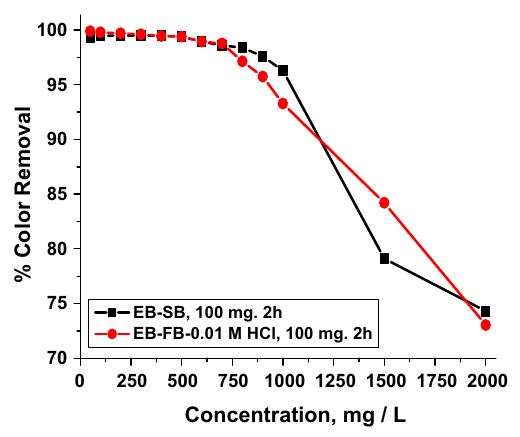
Fig. 7 Effect of dye EB concentration—biomasses SB, FB-0.01 M